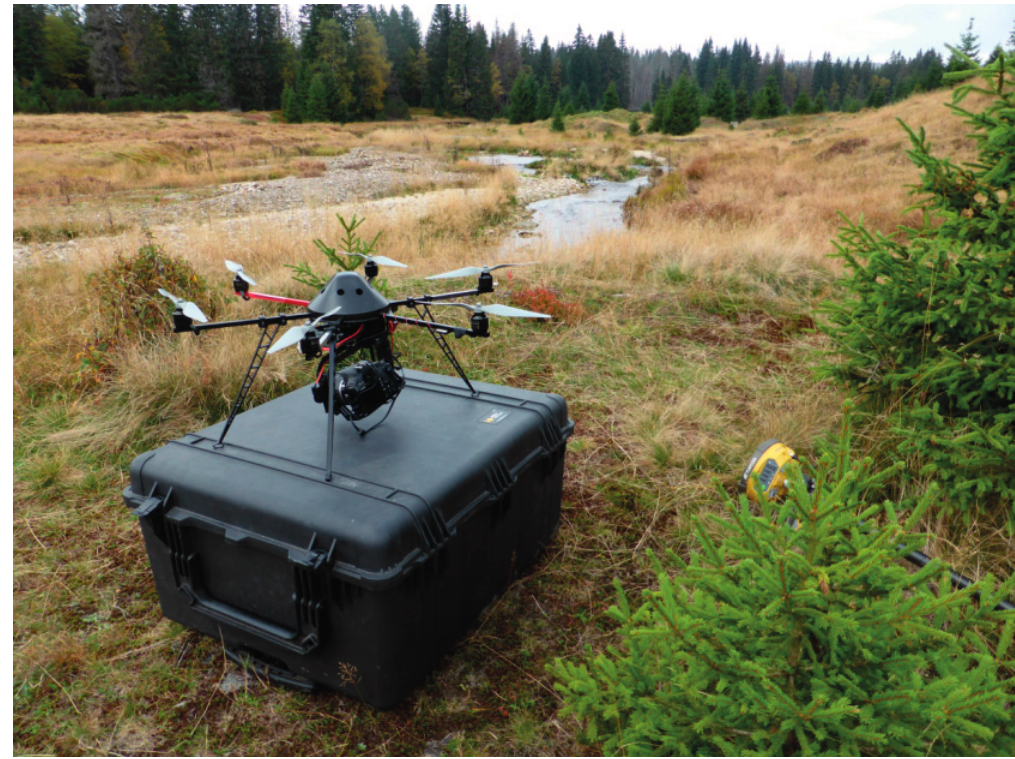
Figure 4. UAS Mikrokopter Hexa XL with Canon EOS 500D camera, used for UAS imaging